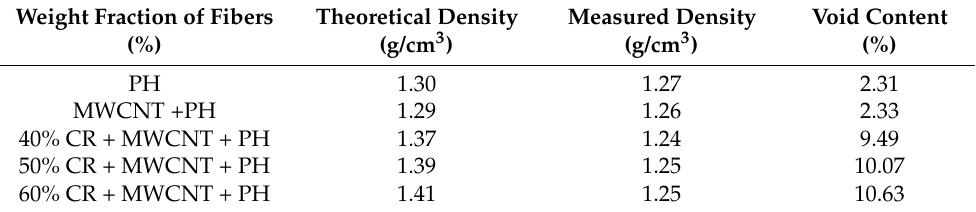
Table 3. Density and void content of CR fiber-reinforced MWCNT-phenolic composites.